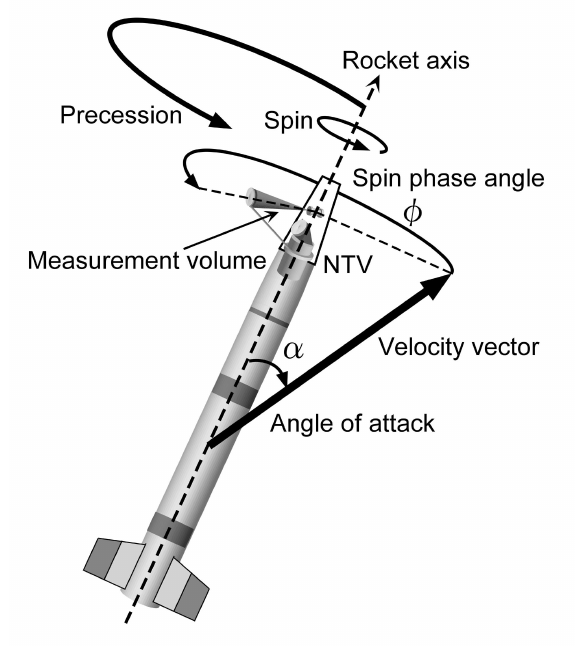
Fig. 1. Definition of the rocket attitude and motion.